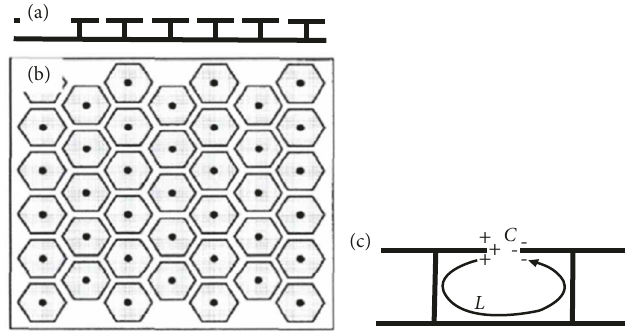
Figure 12: High impedance metasurface